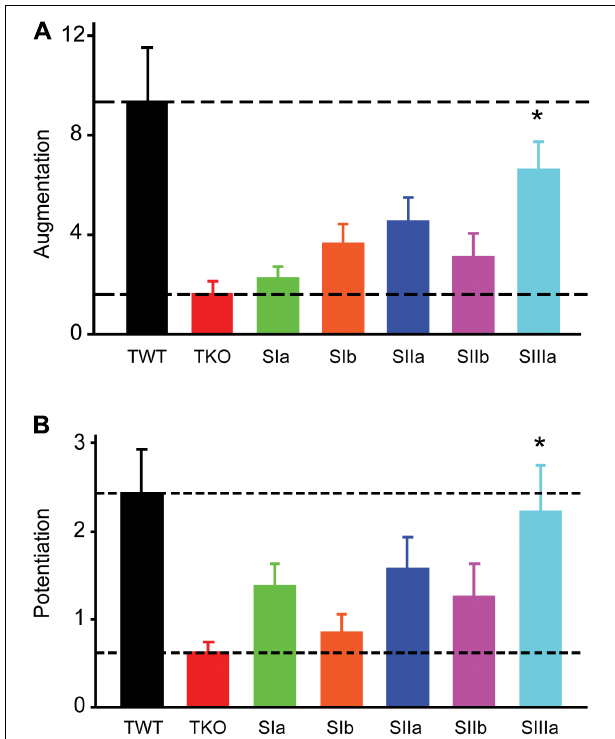
FIGURE 3 | Rescue of augmentation and potentiation defects in TKO neurons by synapsin isoforms. (A) Amplitude of augmentation in TWT (black) and TKO (red) neurons, as well as in TKO neurons expressing indicated synapsin isoforms. (B) Amplitude of potentiation in the same conditions shown in panel (A) . Values in panels (A,B) indicate means, determined as in Figure 2 , error bars indicate ± SEM, and asterisks indicate significant differences compared to values measured in TKO neurons (lower dashed lines).